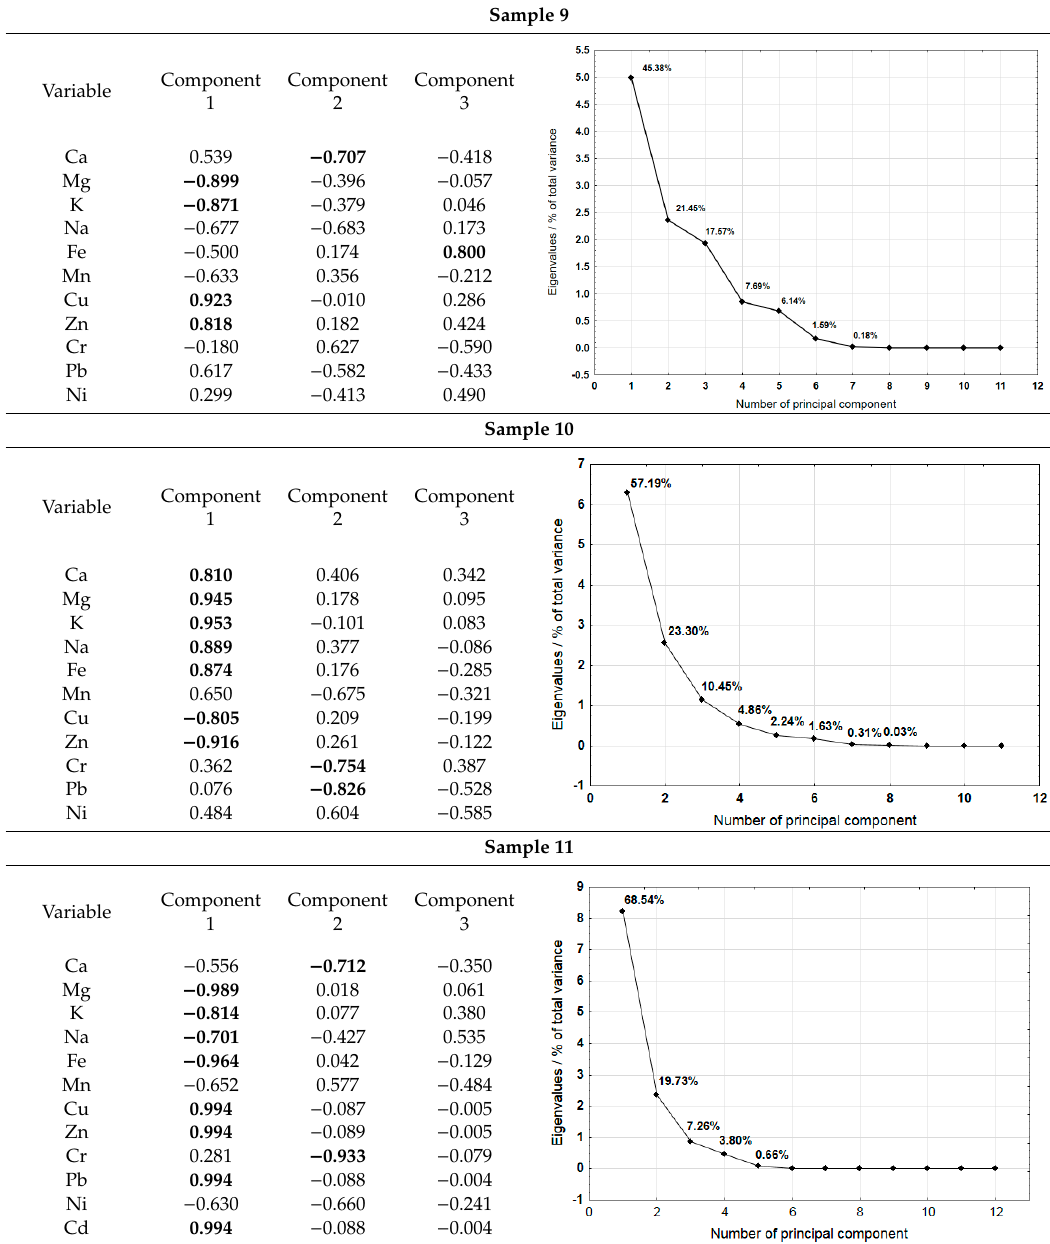
b Figure 8. The appearance of the samples after composting: a ) biodegradable plastic from corn and potato starch (Sample 3), b ) oxo-biodegradable plastic (Sample 9) [photo F. Markowicz] Plastic decomposition was studied under conditions of industrial composting. After completion of the process, the compost is mixed and screened on a drum screen to separate the contaminants from the finished compost. Under these conditions, plastics that are susceptible to mechanical impact will burst and fragment, resulting in compost that will then be used as fertiliser (some technologies also involve grinding compost) [33]. The regulations setting requirements for compost quality often do not take into account the occurrence of physical impurities, which are micro and nanoplastics.